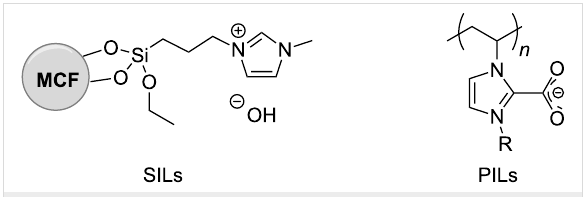
Figure 1: Structures of some representative SILs and PILs systems. MCF is a silica-based mesostructured material with ultra-large meso- pores of 20–50 nm